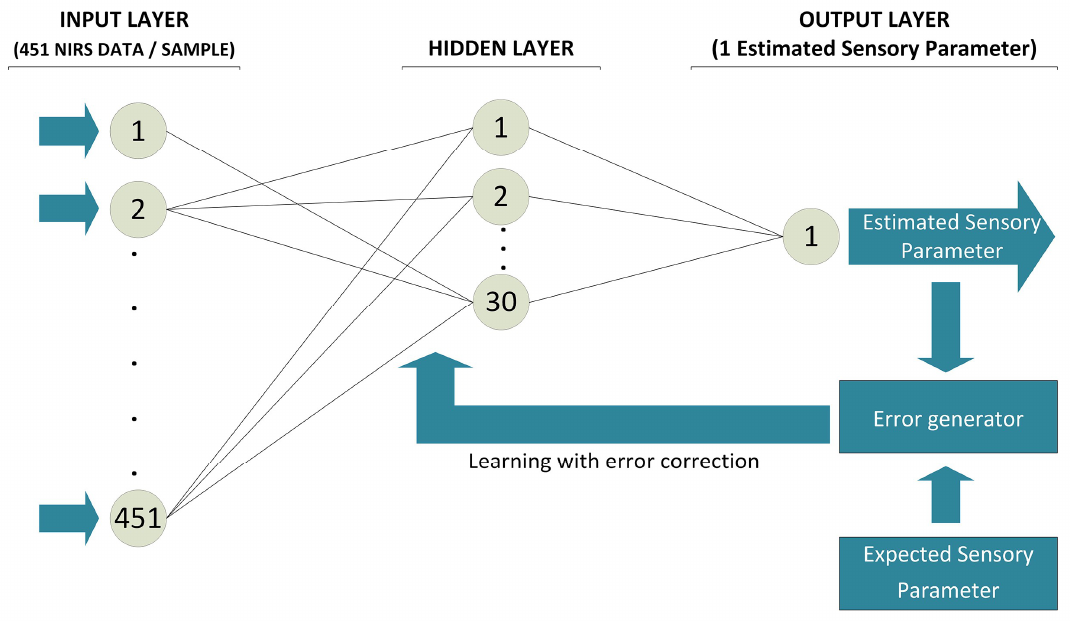
Figure 2. Structure of feedforward multi-layer Artificial Neuronal Network (ANN) for calculating sensory parameters of cured ham; this diagram is repeated for each of the 28 sensory parameters studied.